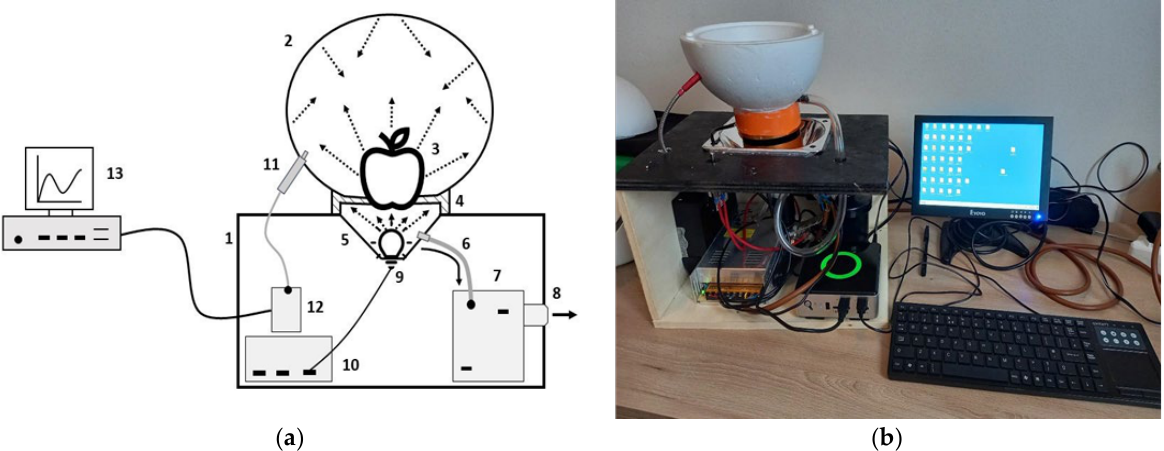
Figure 1. ALT-System (Apple Light Transmittance System) operation diagram ( a ) and ALT-System instrument ( b ).